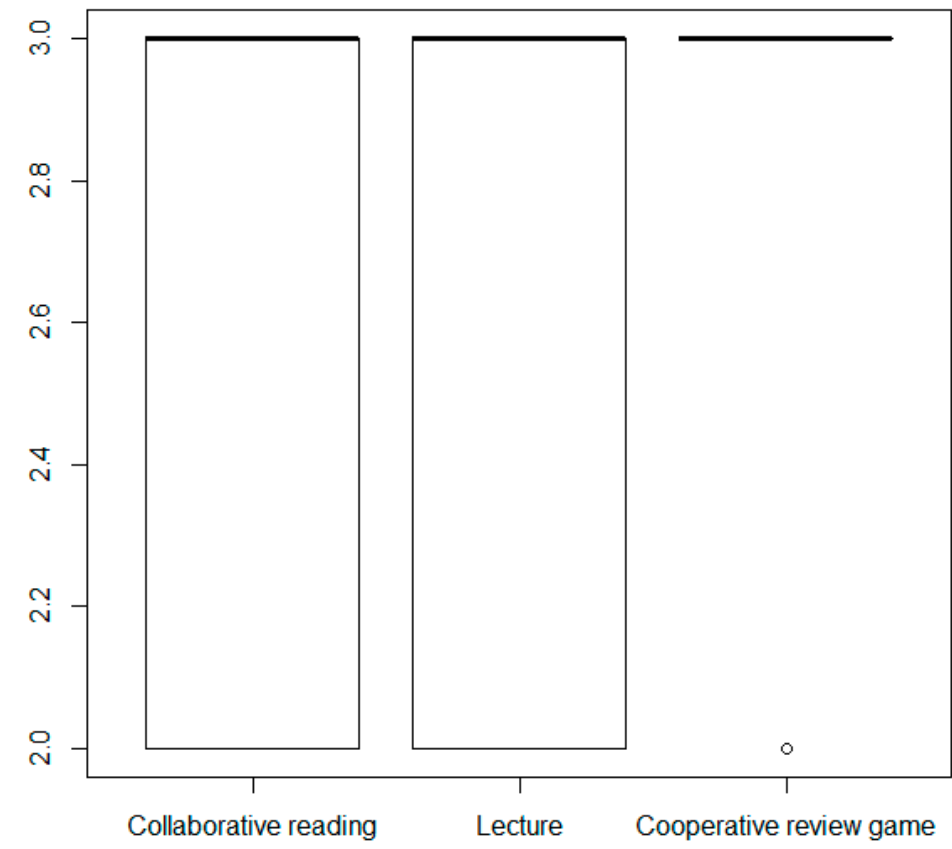
Figure 5. Responses to the question “Socrative seemed appropriate for this type of task: (i) brief readings, battery of short questions, multiple choice, etc. (ii) quick answer; (iii) battery of short questions, multiple choice, etc.”.